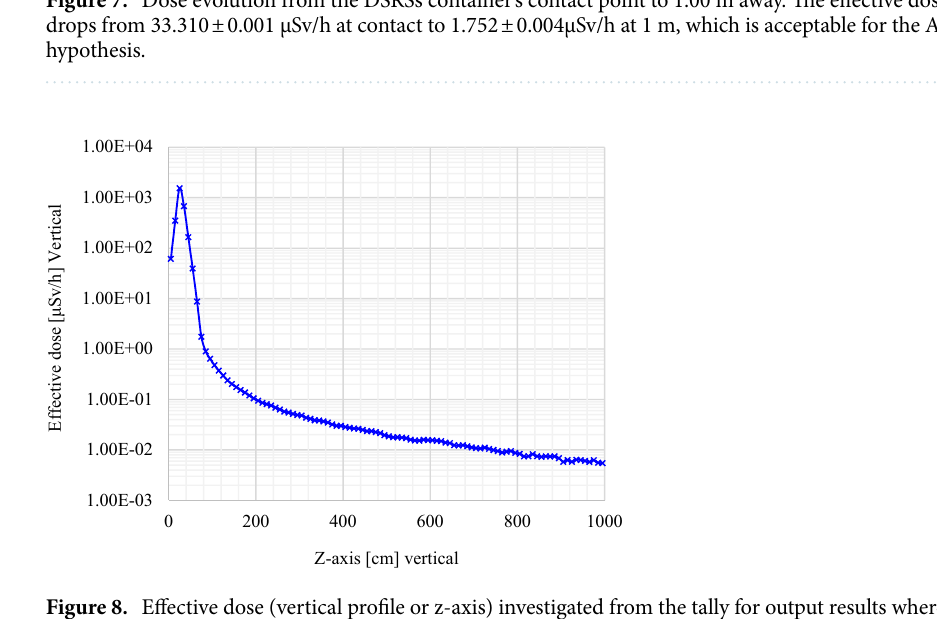
Figure 8. Effective dose (vertical profile or z-axis) investigated from the tally for output results where the interval 0–74.00 cm represents the DSRSs container height and the interval 74.00–1000.00 cm corresponds to the closest area on top of the encapsulated waste to be disposed